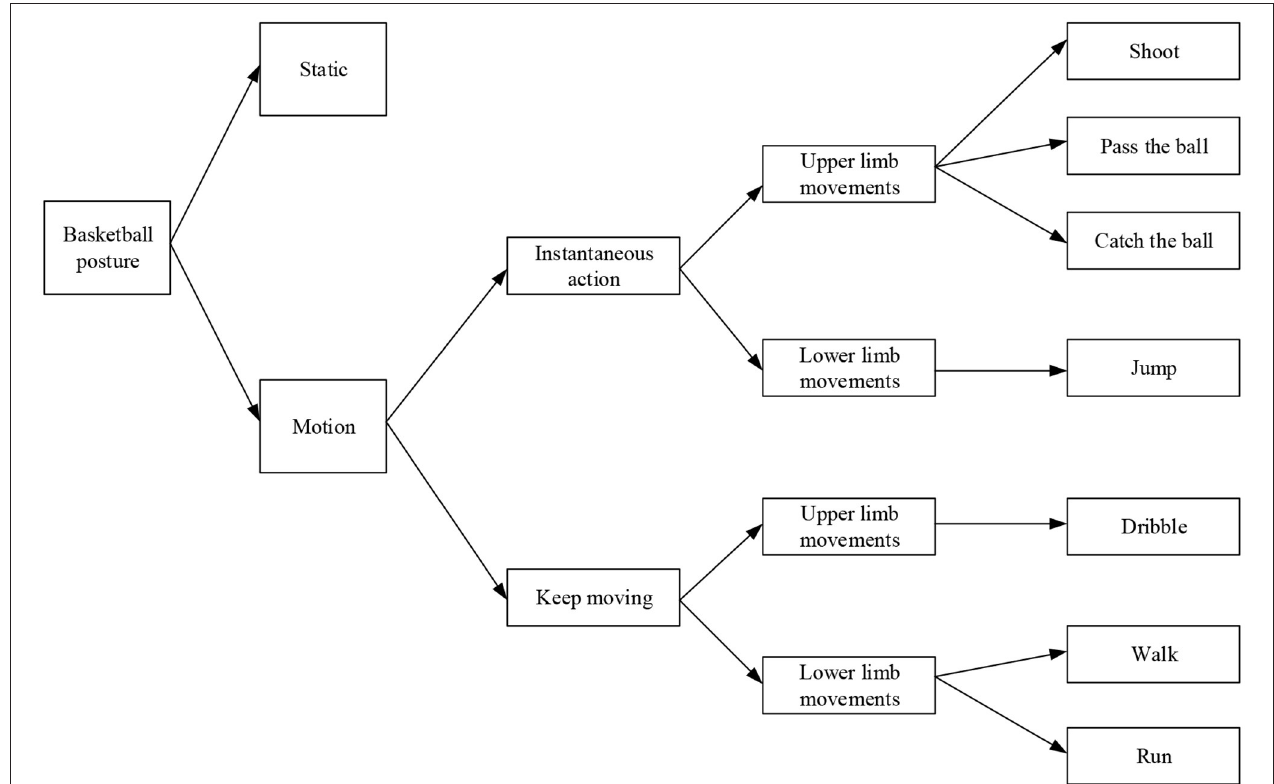
FIGURE 2 | Composition of basketball training